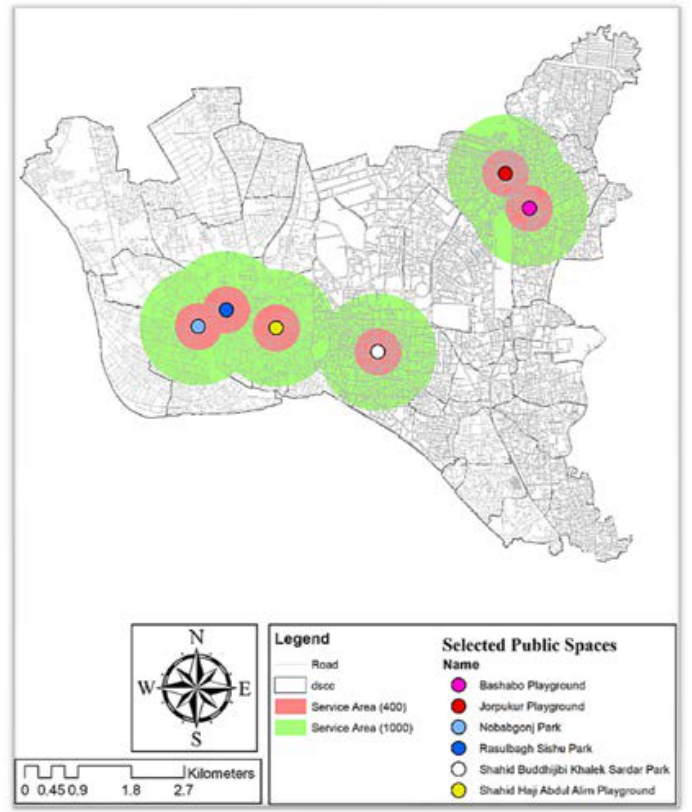
Fig. 6: Service area of the public spaces Table 5: Public space wise major problems